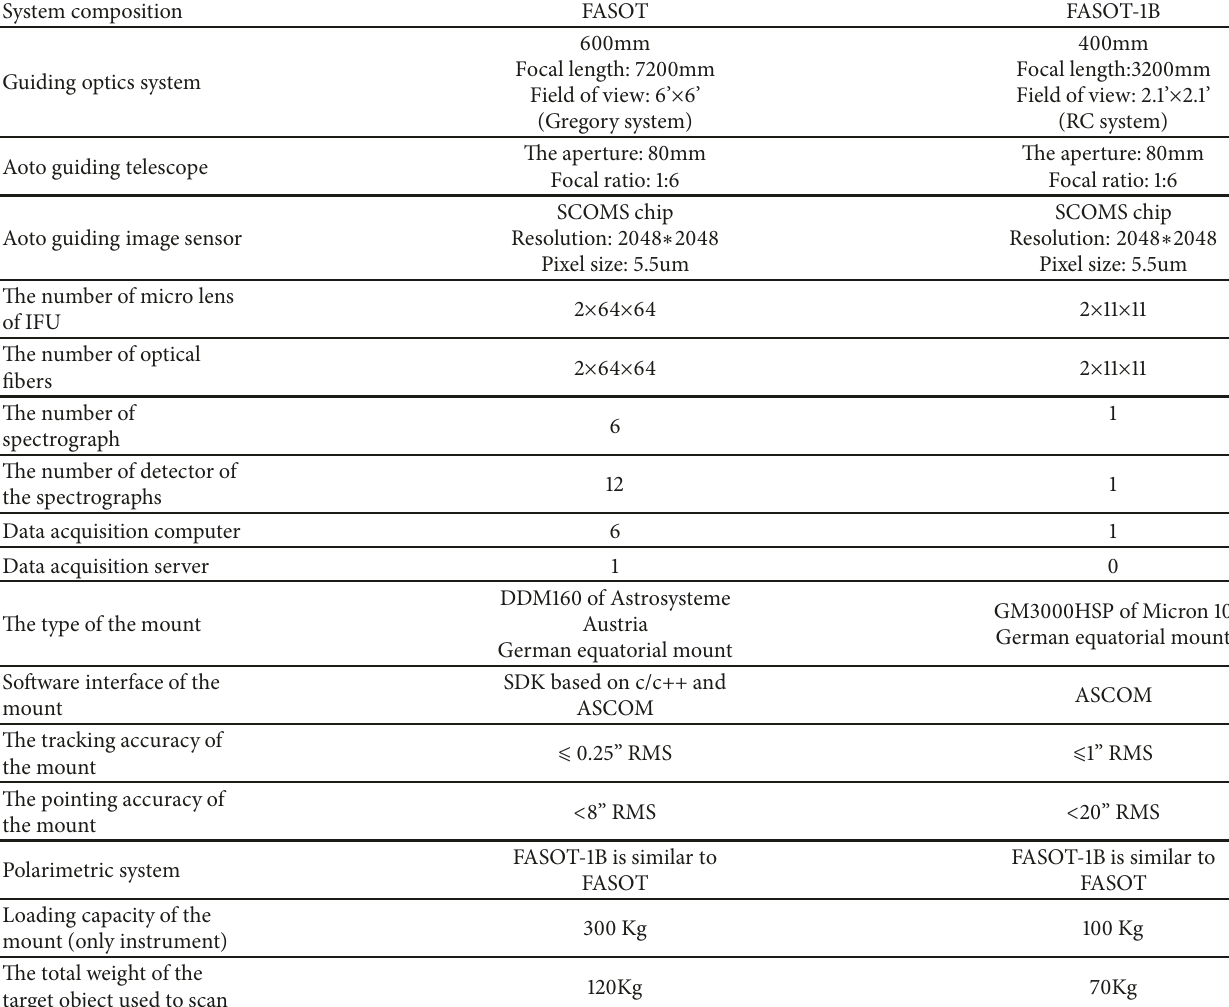
Table 1: The distinctions between FASOT and its prototype